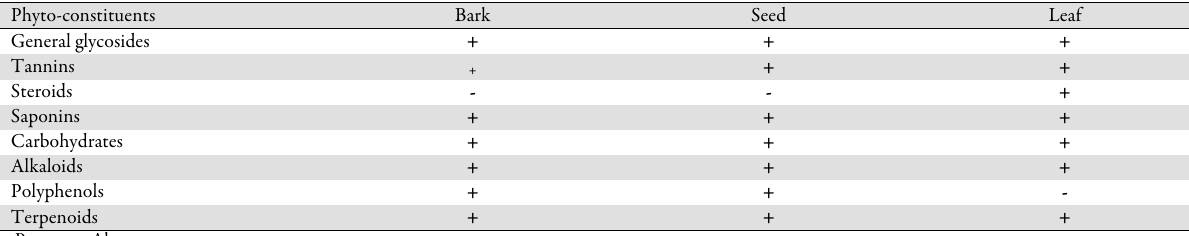
Table 2. Antimicrobial activity of V. paradoxa extracts against Staphylococcus aureus Concentration (mg/ml)